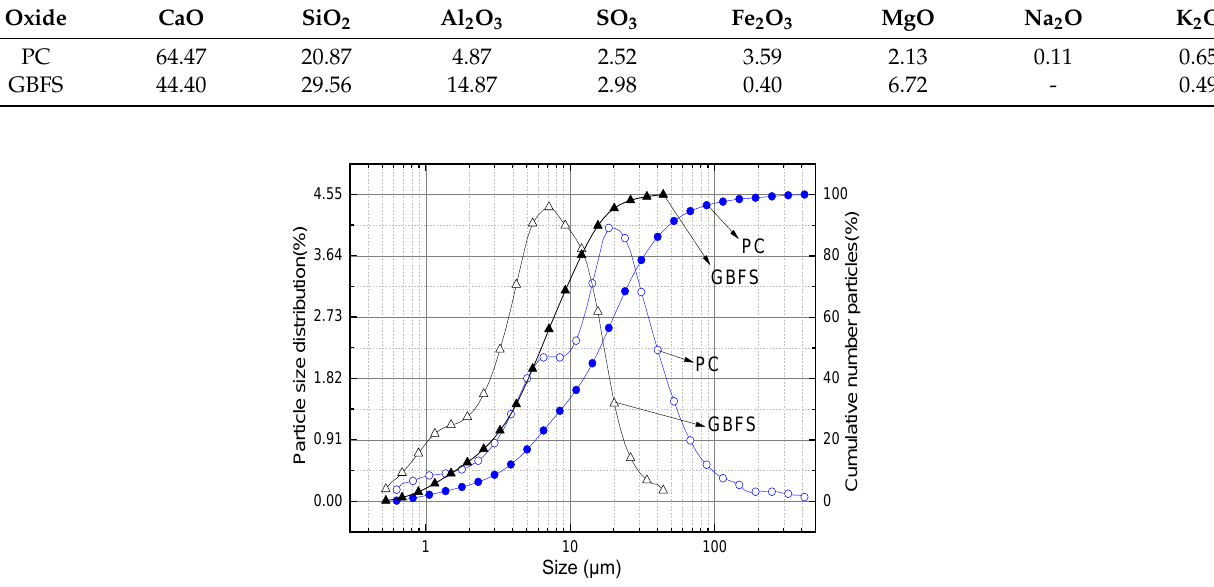
Table 1. Chemical composition of PC and GBFS, wt.%.